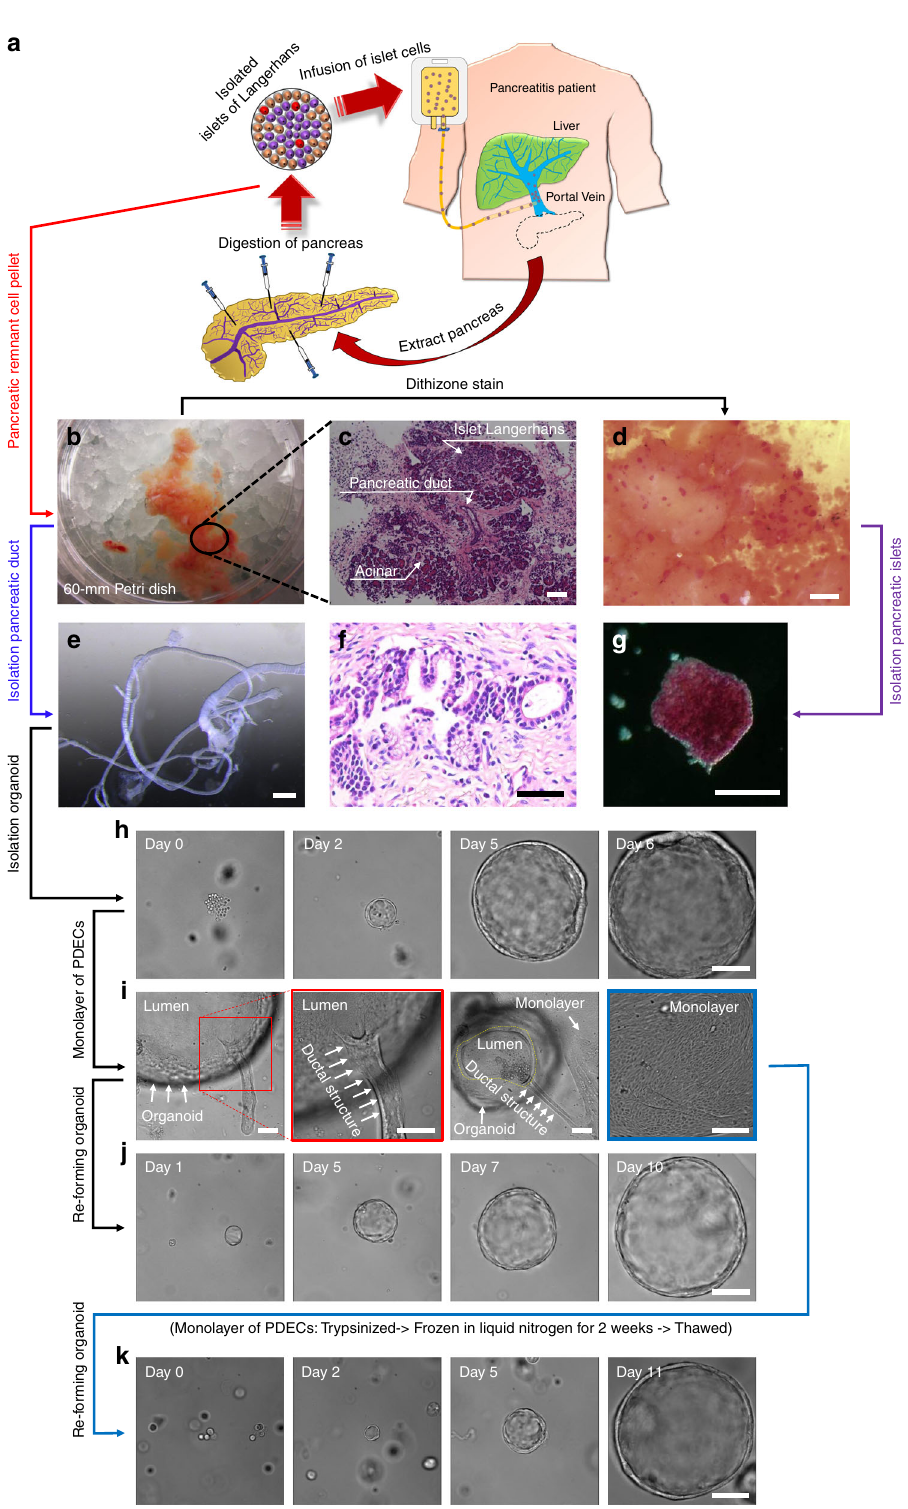
on the apical membrane of the ductal epithelial cells (Fig. 2k). Polarized monolayer of PDECs on a porous membrane in a pancreas-on-a-chip was examined with immuno fl uorescence image of ZO-1 and measurement of transepithelial electrical resistance using epithelial volt-ohm meter (Supplementary Fig. 3). We performed RNA-sequencing in these organoids and veri fi ed that the organoids were of human PDECs in origin (Fig. 2l). Epithelial cell markers, cytokeratin family proteins (KRT